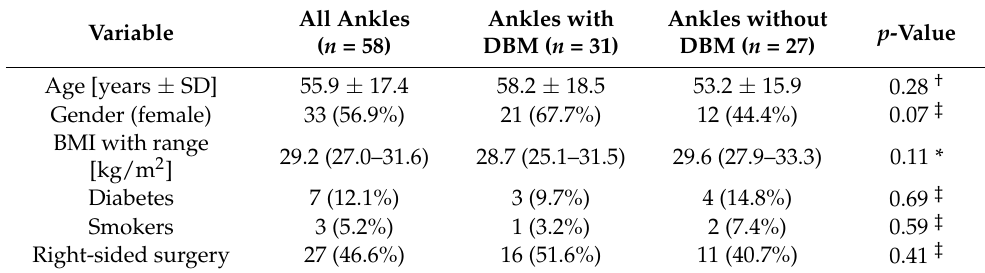
Table 1. Demographics and clinical characteristics.